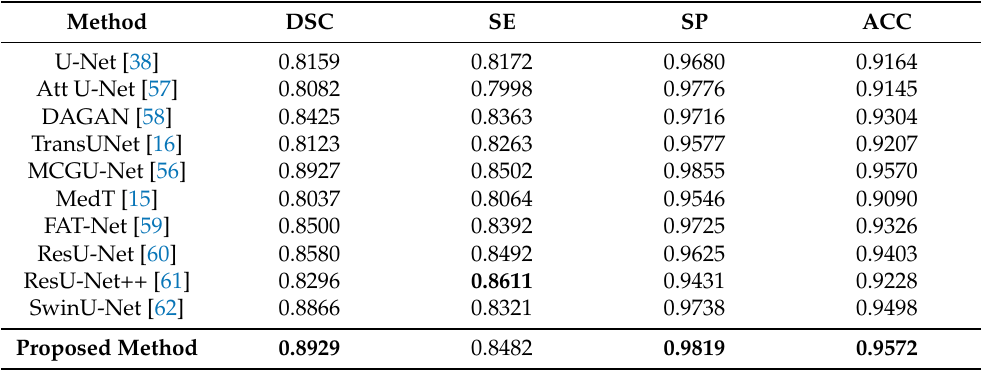
Table 1. Comparison results of the proposed method against the SOTA approaches on the ISIC 2017